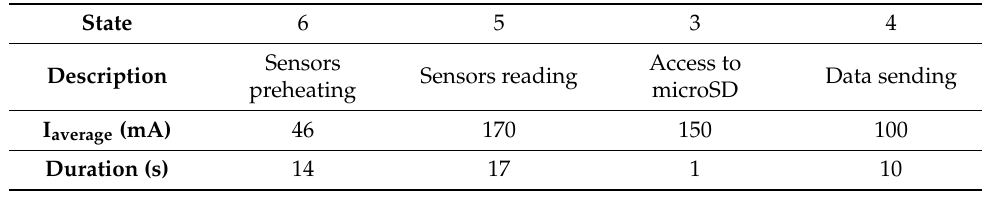
Figure 9. Node B—mode (ii): Sensor reading and data sending (every 30 min). Table 7. Description of functional states of node B—mode (ii).